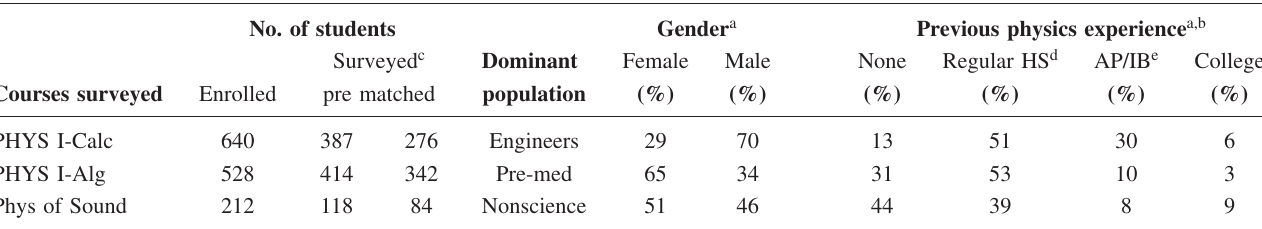
TABLE I. Demographic information for courses surveyed.